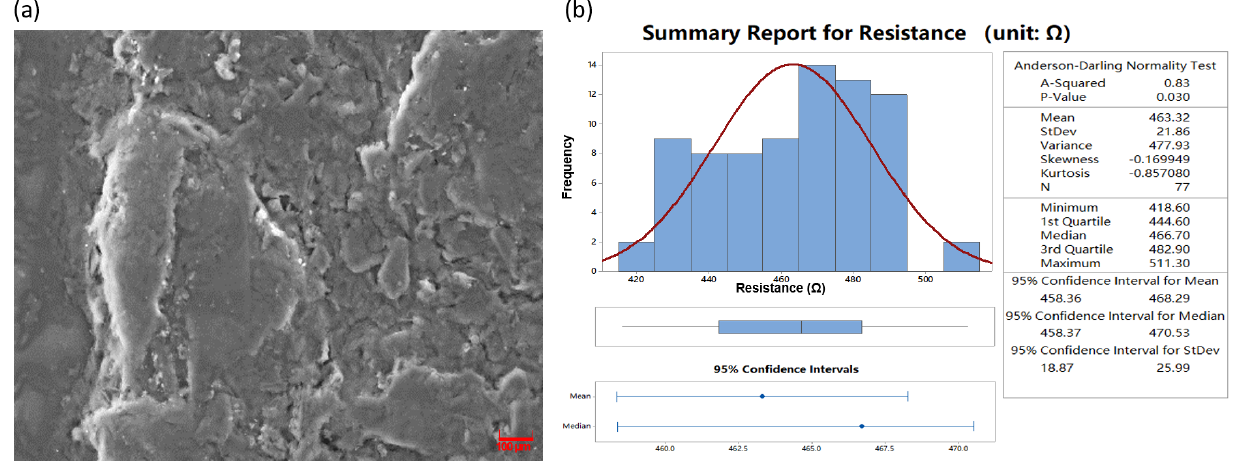
Figure 3. ( a ) The SEM picture of the resistive sensor; ( b ) distribution of the resistance values made by the screen printing.